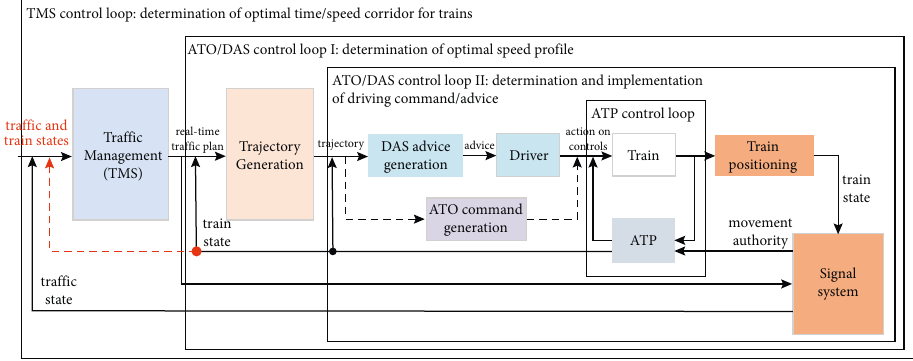
Figure 1: Integrated traffic and train control